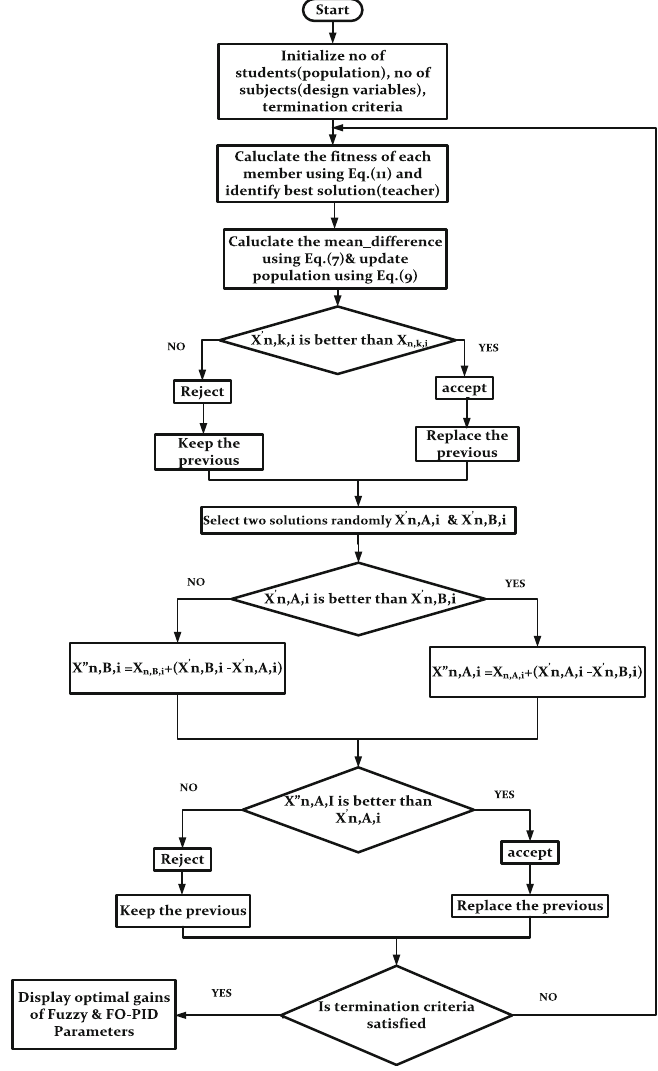
Fig. 8 Flow chart for the tuning of proposed controller with TLBO